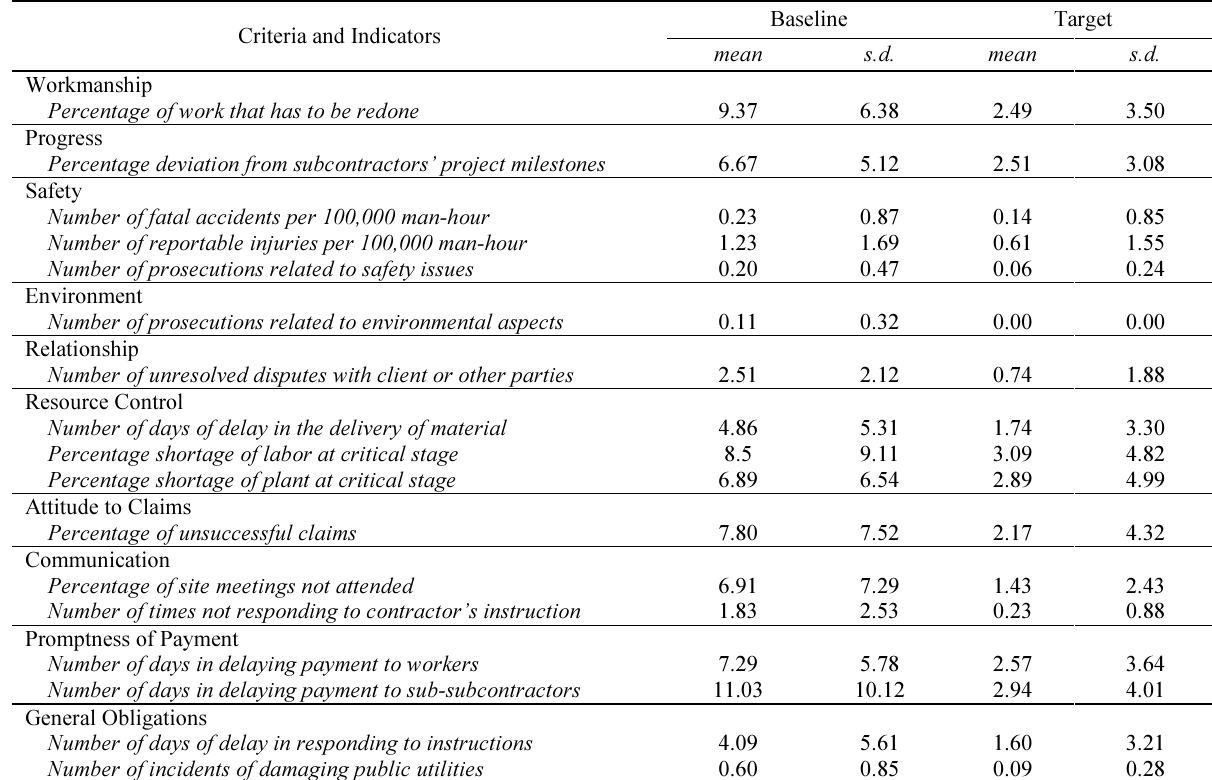
Table 2. Baseline and target performance levels Criteria and